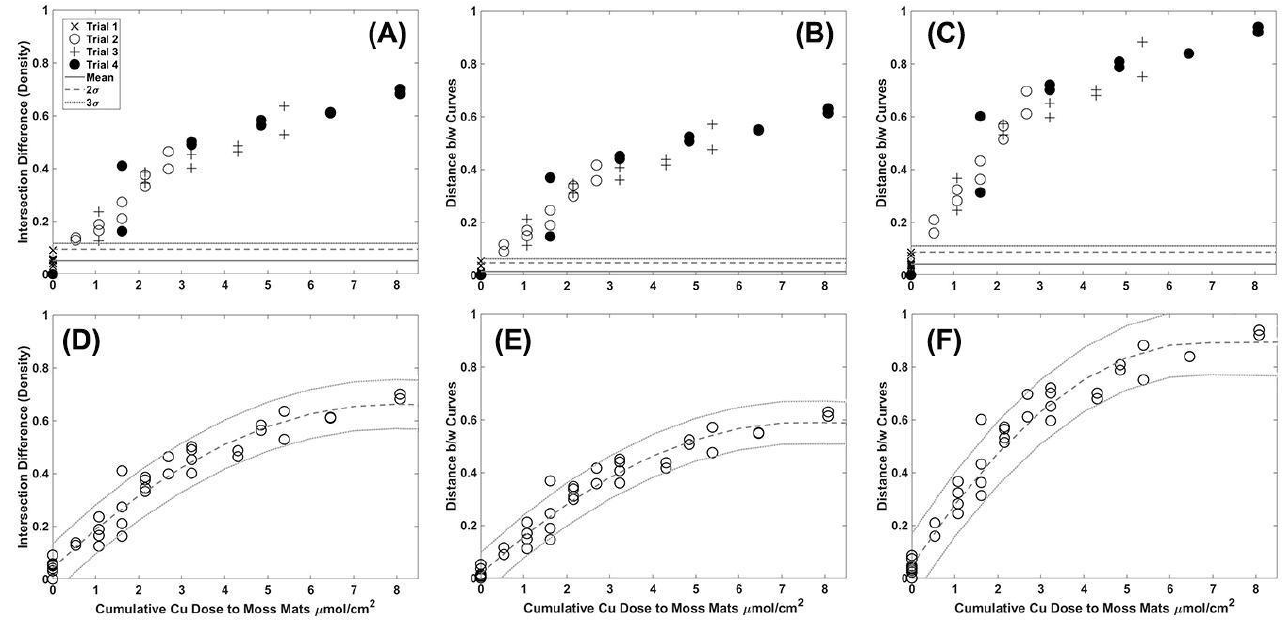
Figure 10. Red color histogram differences ( A ), DTW ( B ), and red versus green DTW ( C ) for each trial on each day of the experiment relative to their day-0 control plotted against the cumulative Cu dose. The 2 σ (dashed line) and 3 σ (dotted line) confidence intervals are shown for the mean of trial 1. ( D – F ) show a curve fitting through all data points corresponding to dose ( A – C ). As seen in ( D – F ), the root mean squared errors with 95% confidence were 0.0464, 0.0406, and 0.06059, respectively.